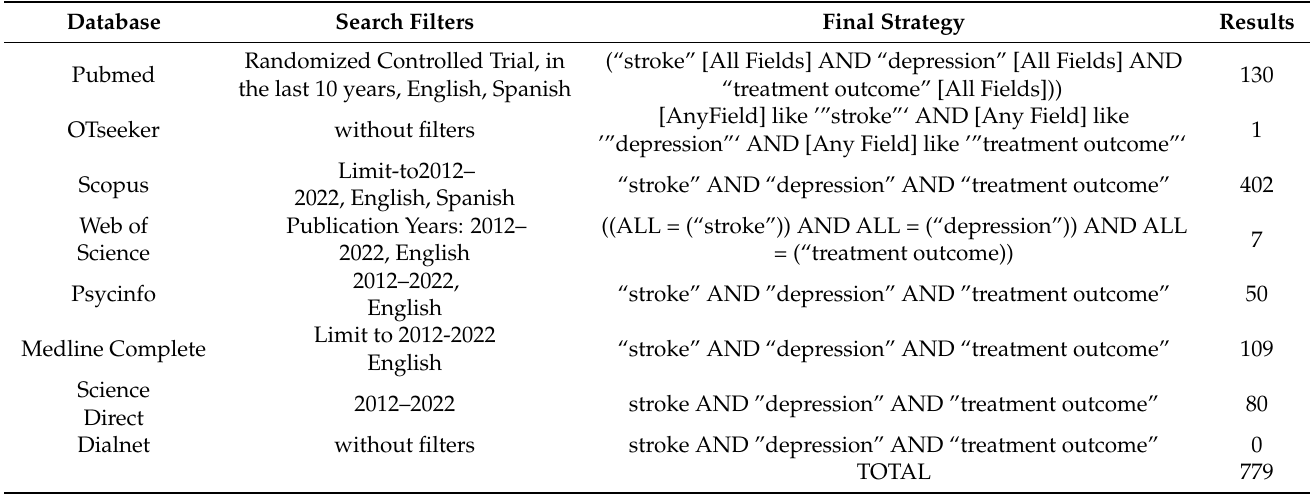
Table 2. Final strategy of searching in Databases with